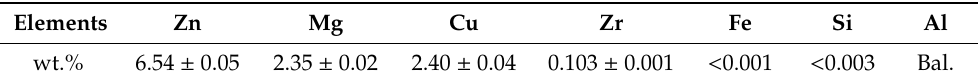
Table 1. Composition of high alloyed Al-Zn-Mg-Cu aluminum alloy.